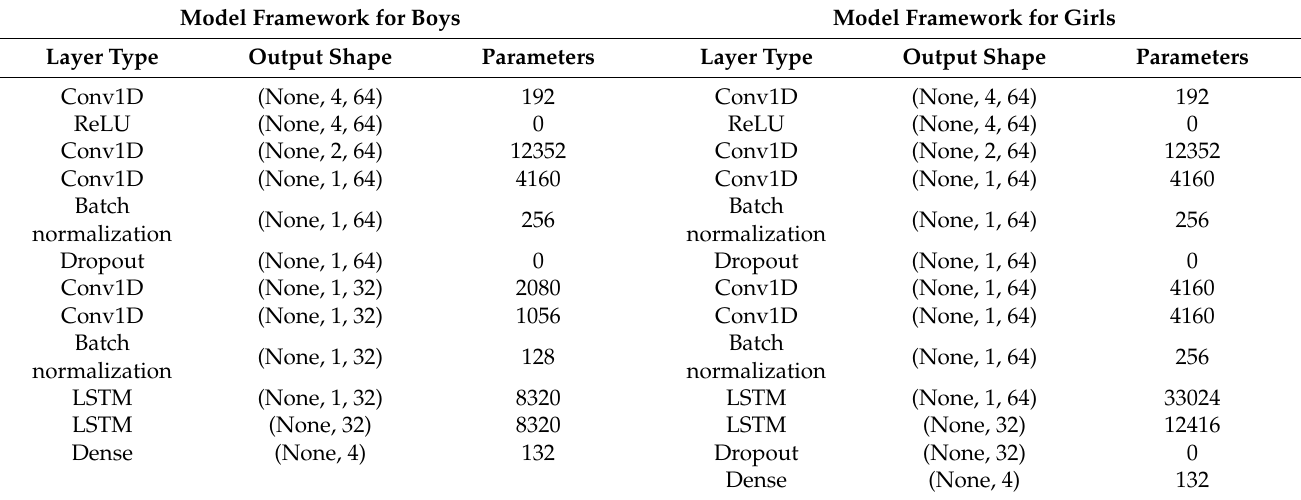
Table 6. The framework of teenagers’ physical fitness evaluation models.